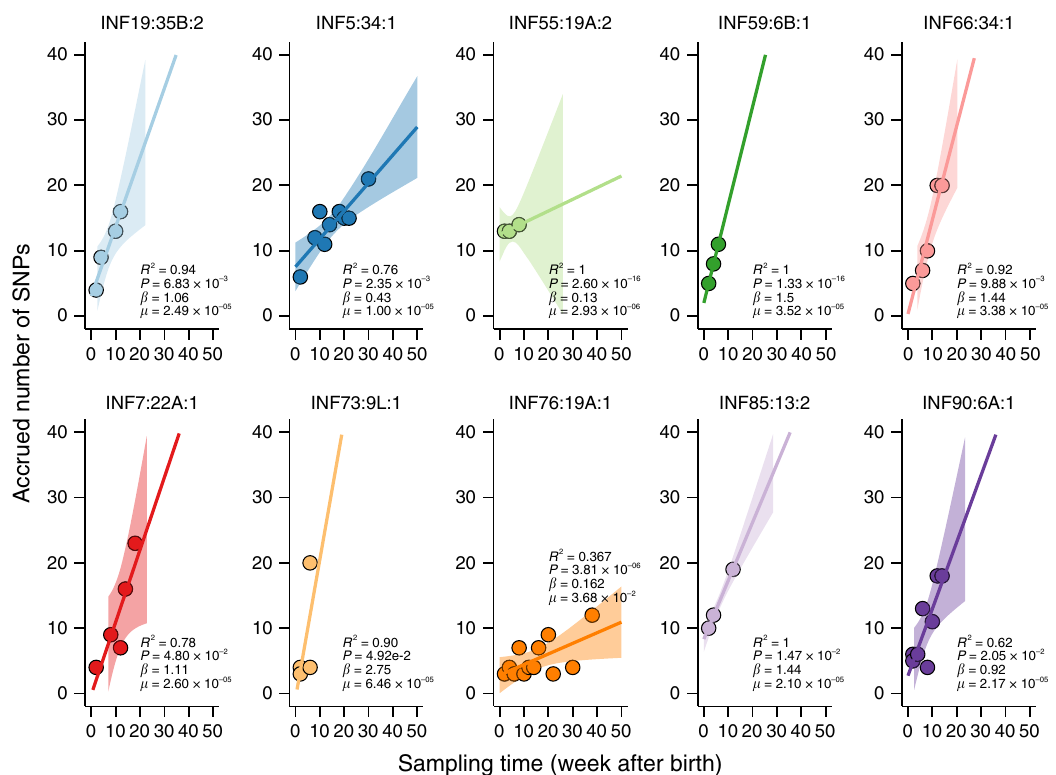
Fig. 5 Within-host mutation rates during natural colonisation. Episodes where molecular-clock signal was evident were analysed. Serotypes with >4 sequenced genomes per individual were included in the analysis. The episode name is shown in the format A:B:C where A, B and C represents the infant ID, serotype and number of episodes with the serotype respectively. Linear relationship between the number of accrued SNPs in comparison with the reference genome sequenced at the onset of the episode was assessed using linear regression. The nucleotide substitution rate ( μ ) corresponded to the estimated number of SNPs site − 1 year − 1 based on the regression coef fi cient ( β ). The units of β , i.e., the mutation rate expressed as the number of SNPs per week. The shaded area surrounding the fi tted linear regression line represent the 95% con fi dence interval based on the standard error of the mean slope of the regression line. The values of the substitution rates expressed as SNPs site − 1 year − 1 are shown in Table 2. Table 2 Within-host nucleotide substitution rates during natural colonisation.